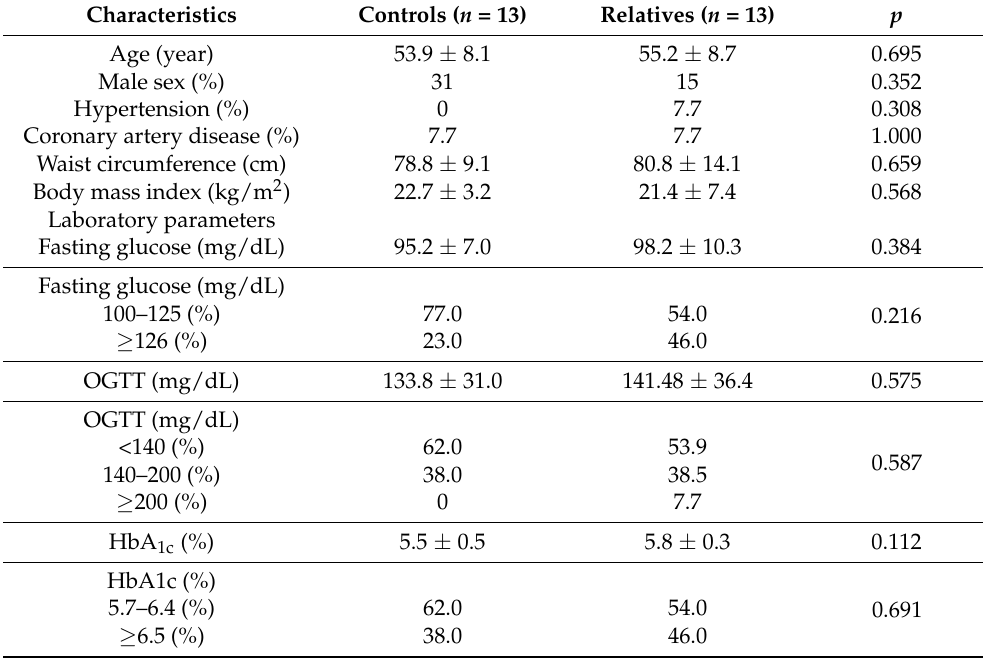
Table 8. Comparison of clinical characteristics between controls and spouses of DM patients by age, sex and BMI